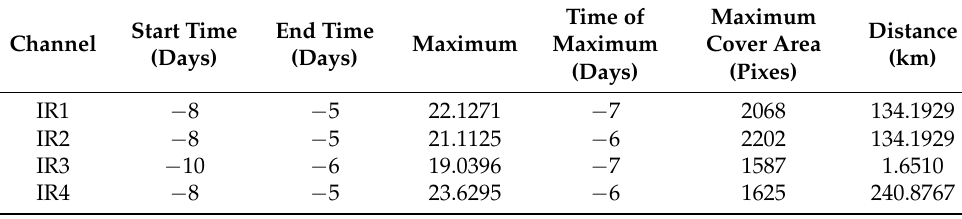
Figure 15. The cover area of the anomalies before and after Taiwan earthquake. Table 4. The spatial–temporal characteristics of anomalies before the Taiwan